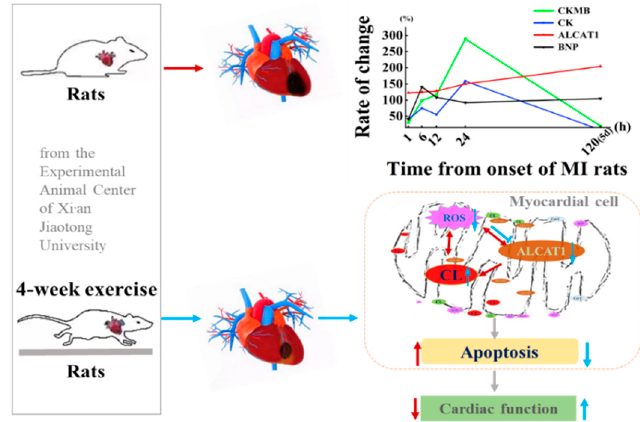
Figure 10. Proposed mechanism by which exercise-induced cardioprotection protects against myocardial infarction (MI)-induced injury in the heart. Exercise training inhibits the production of ALCAT1 in circulation and cardiac tissues and exerts cardioprotective effects against MI-induced injury by suppressing myocardial apoptosis and enhancing antioxidant activity.